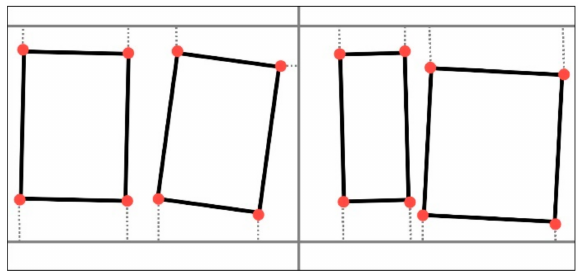
Figure 6. Buildings (black continuous), point sets (red), Dist S (grey dashed), and streets (grey continuous).